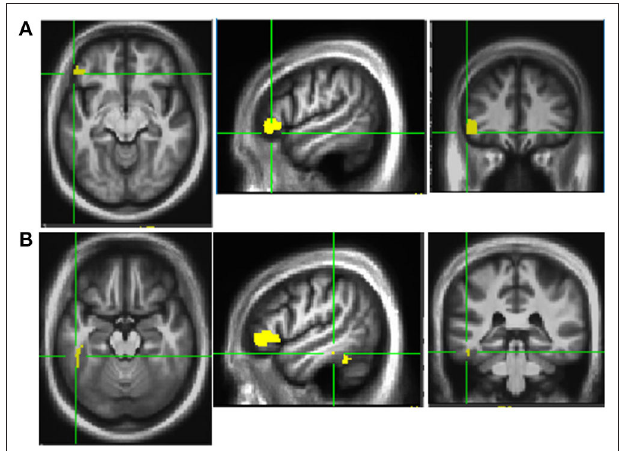
FIGURE 2 | Activation patterns Post-PDAE. Increased activation was noted in left inferior frontal gyrus area 45 (A) and inferior temporal gyrus area 20 (B) at post compared to baseline after 12 weeks of